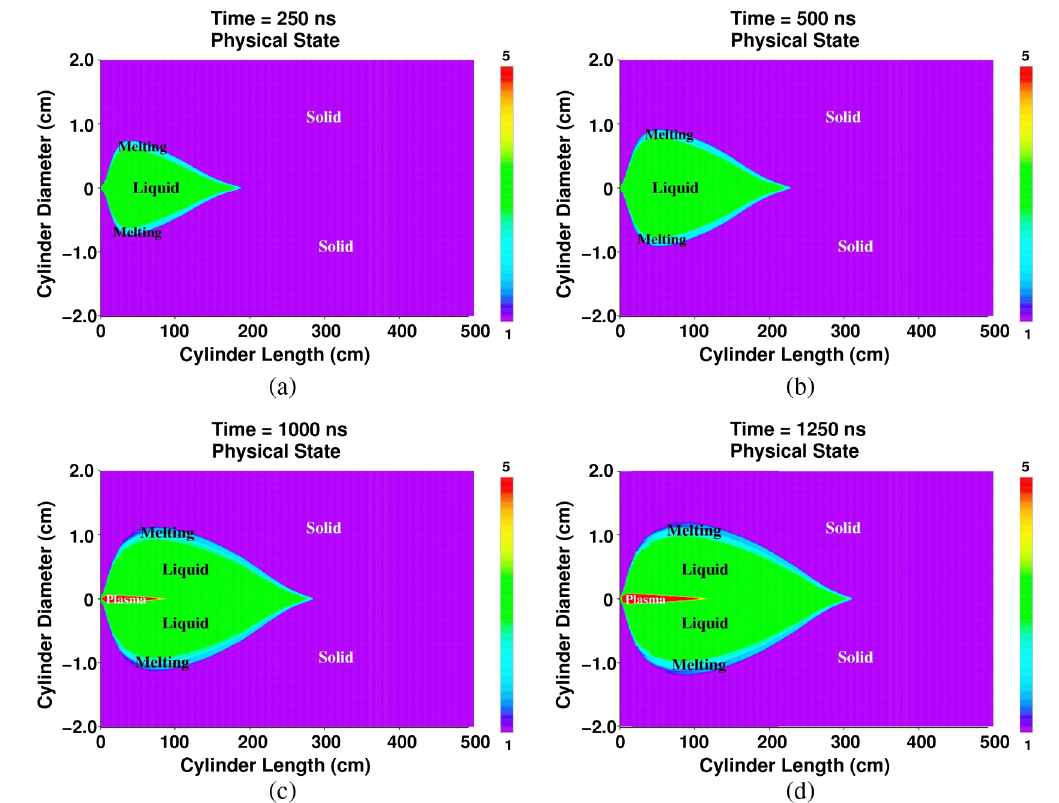
FIG. 11. Target physical state calculated by BIG 2 (a) at t ¼ 250 ns (10 bunches delivered), (b) at t ¼ 500 ns (20 bunches delivered), (c) at t ¼ 1000 ns (40 bunches delivered), and (d) at t ¼ 1250 ns (50 bunches delivered).